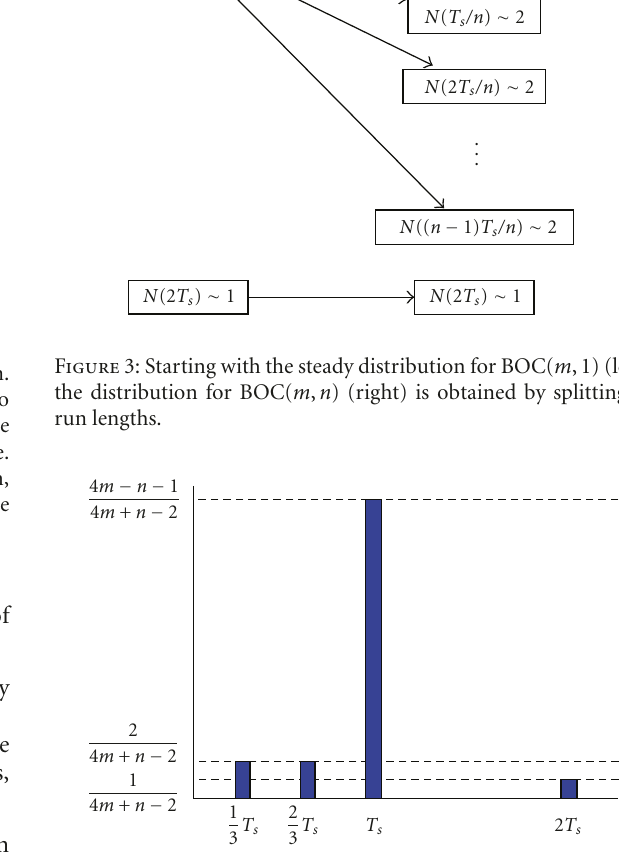
Figure 4: Run length histogram of a BOC(5,3)